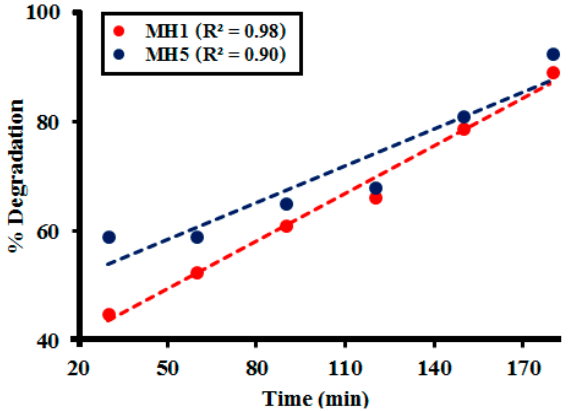
Figure 5. Correlation between time and percentage degradation of alizarin red (AR) dye (250 ppm) by 0.025 g of nanomaterials MH1 and MH5.